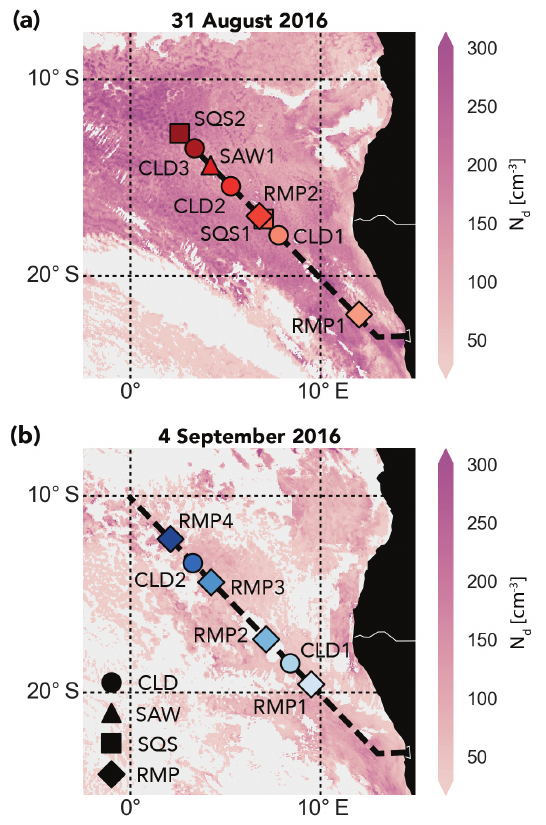
Figure 3. Map of the SEA region with the location of relevant flight legs for the (a) 31 August and (b) 4 September flights shown in shades of red and blue, respectively. The flight track of the P-3 for each day is given by a dashed black line. Background shading is N d from SEVIRI (12:15UTC) screened for MBL